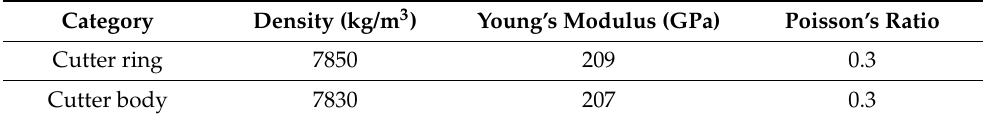
Figure 7. Cutter ring and cutter body. Table 2. Disc cutter material characteristic parameters.